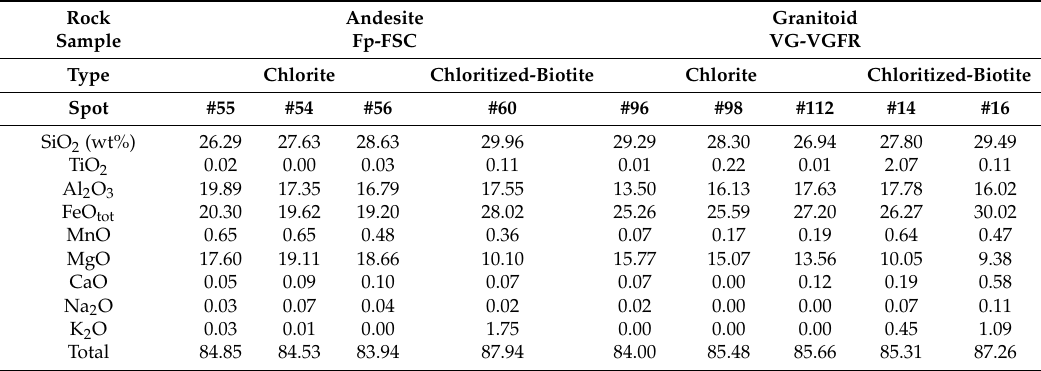
Table 3. Representative Electron Microprobe analyses and chemical formulae of chlorite from Isadalu magmatic